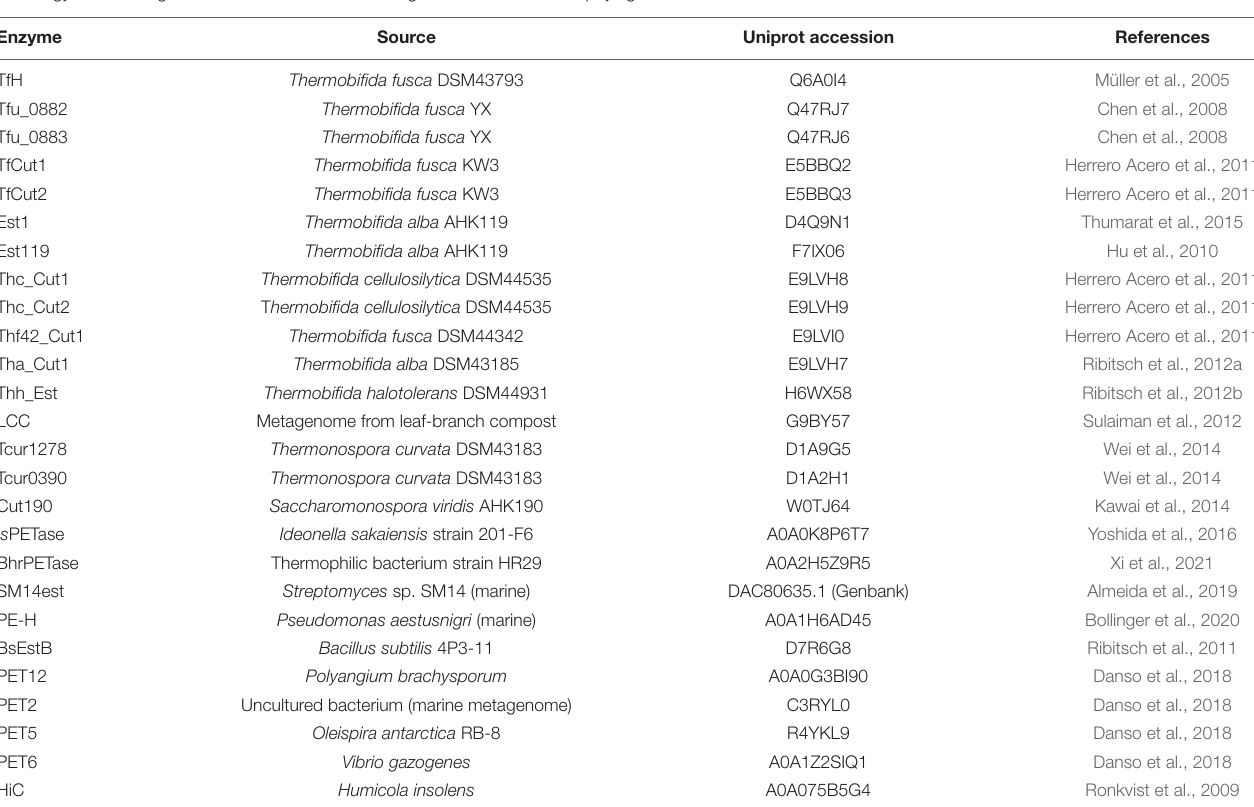
TABLE 2 | Reference dataset of functionally verified polyesterases having activity on PET or PET model substrates, which was used to conduct BLASTP protein homology searches against the B129SM11 annotated genome and for further phylogenetic inferences.